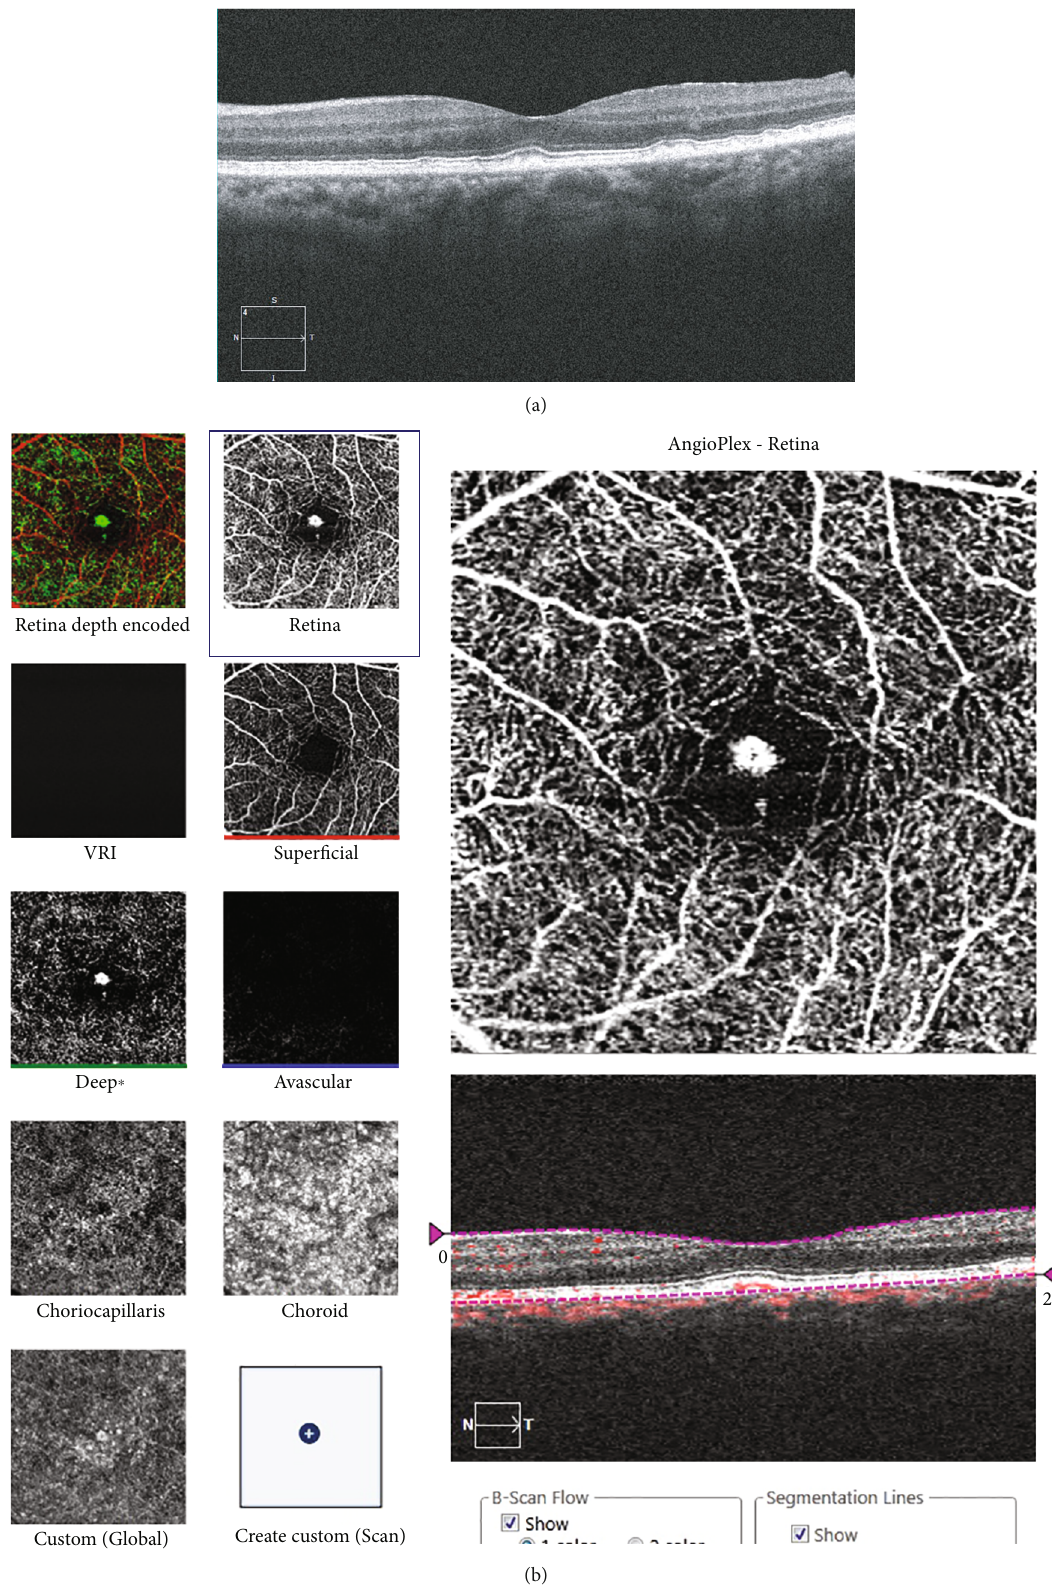
Figure 2: Horizontal optical coherence tomography (OCT) B-scan of the left eye (a) and OCT angiography of the left eye